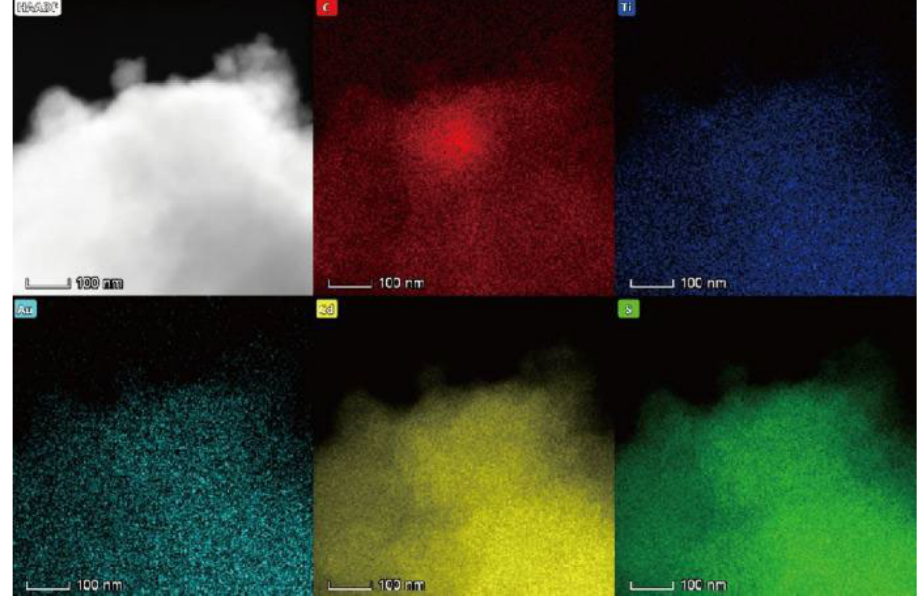
Figure 8. TEM images and elemental mapping images of MXene@Au@CdS nanocomposite [67].